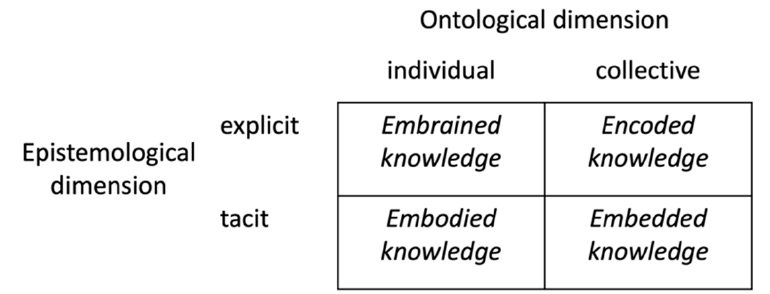
Figure 1. Logics for decision making in respect to different types of knowledge.